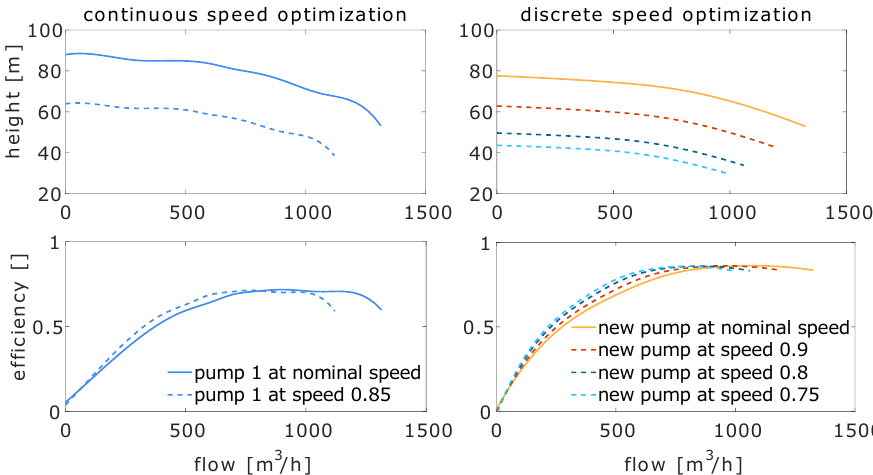
Figure 11. Characteristic curves and efficiency curves of the pumps used in the optimization runs.